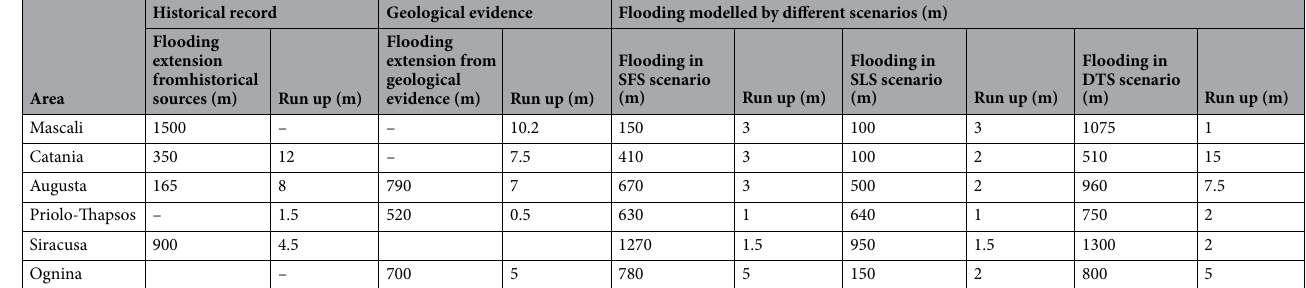
Table 3. Inland flooding assessed through historical record, geological evidence and numerical models for the areas of Mascali, Catania, Augusta, Priolo-Thapsos, Siracusa, Ognina (see Fig. 3 for